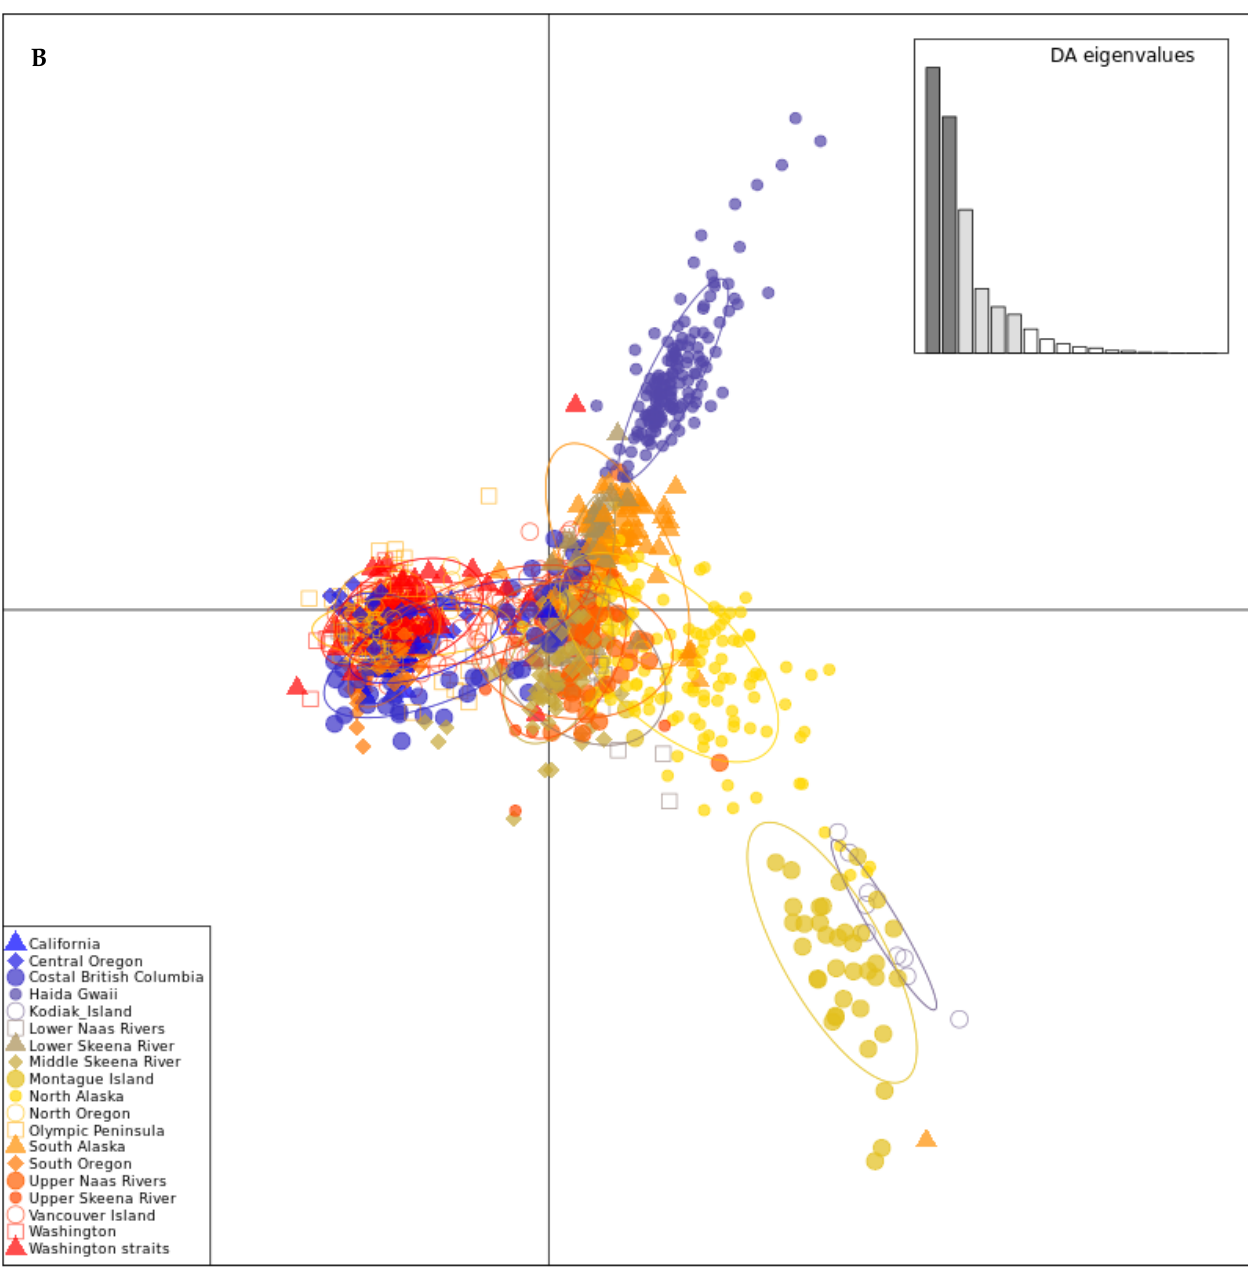
Figure 2. Genetic structure of the Sitka spruce IUFRO population. All 19 distinct geographic regions are represented here. ( A ) Principal component analysis (PCA) performed with adegenet, using 1400 principal components. ( B ) Discriminate analysis of principal components (DAPC) supervised clustering (with geographic regions as prior) performed with adegenet, using 20 principal components and 6 discriminate analyses.